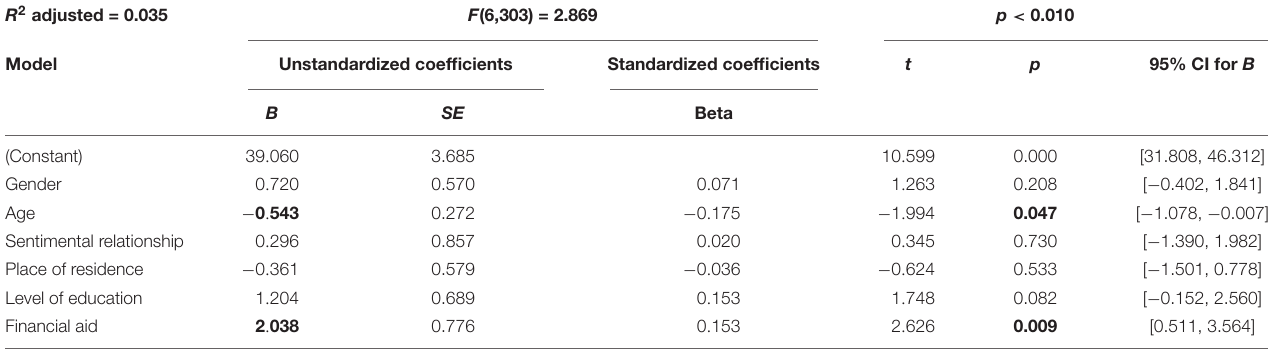
TABLE 5 | Linear regression analysis of the demographic determinants of adolescents’ “attitudes and risk perceptions” toward COVID-19. R 2 adjusted = 0.035 F (6,303) =